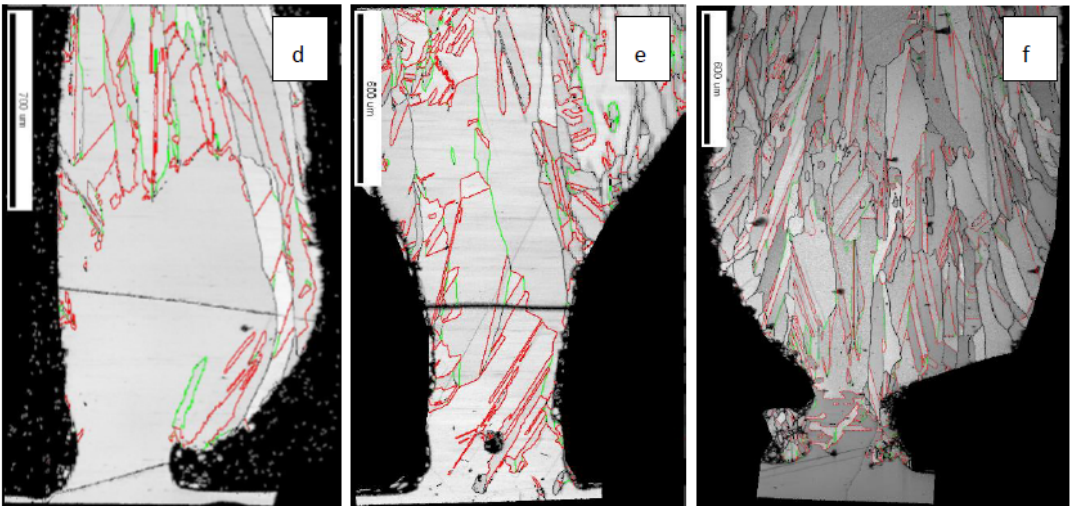
Figure 3. Electron backscatter diffraction (EBSD) mapping of pillars built with pulse energy of 161